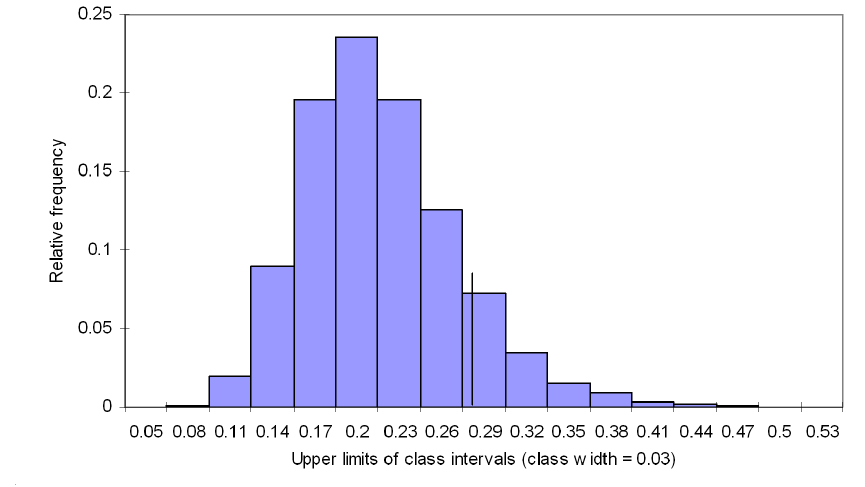
Figure 1: Histogram of largest C p influence measures in 10 000 bootstrap